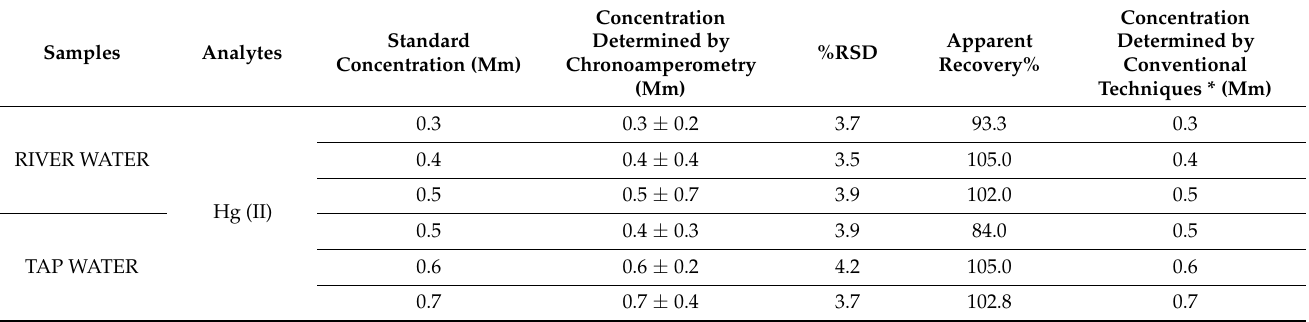
Table 3. Quantification of Hg 2+ in river and tap water samples. (*) refers to the ICP analysis of Hg 2+